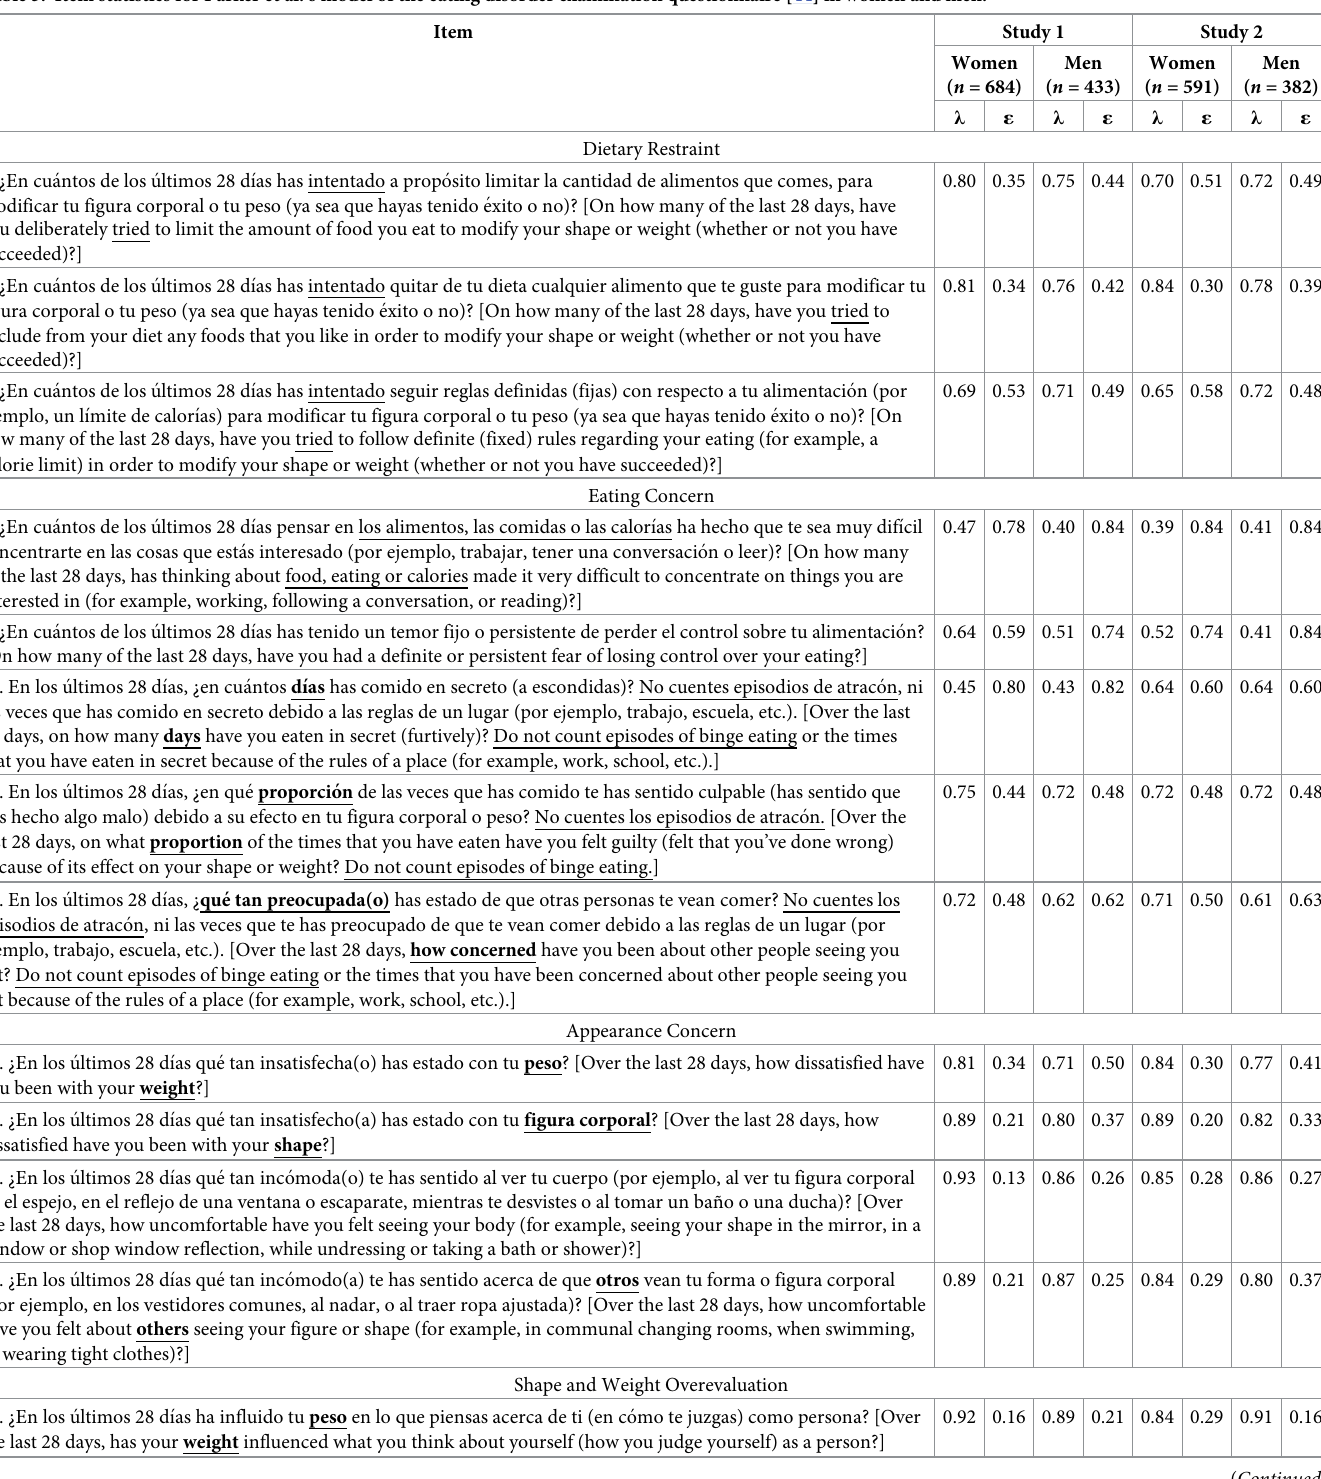
Table 3. Item statistics for Parker et al.’s model of the eating disorder examination questionnaire [44] in women and men. Item